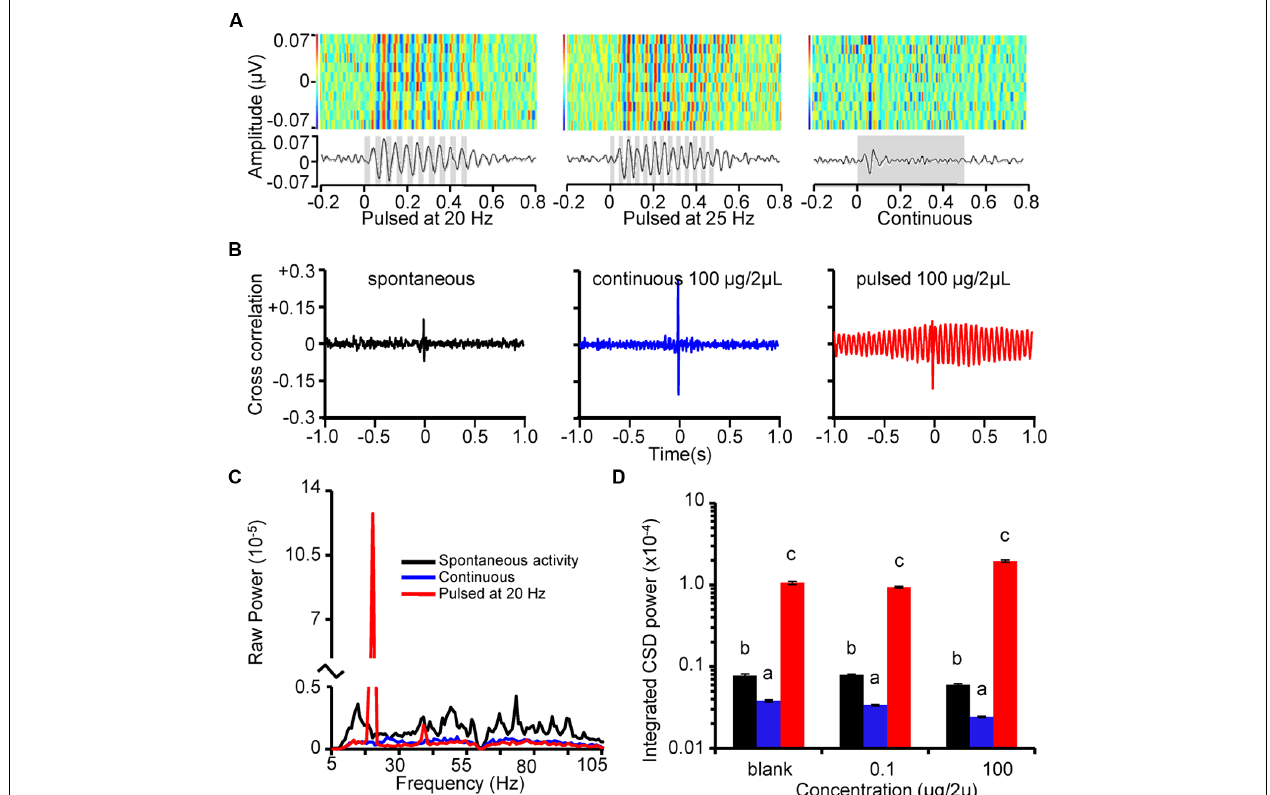
between LFPs and units during spontaneous activity (left), and in response to K6 (100 μ g in 2 μ L mineral oil) presented as a continuous stimulus (center), or a 20 Hz pulse train (right). (C) Mean cross spectral density across all possible analyzed cross correlations. Results based on 80 individually calculated cross correlations across 4 pulse tracking units, 4 LFP recording sites, and 5 stimulus repeats. (D) Mean integrated CSD power in the cross correlations around the pulsing frequency. Results are color coded as in B and broken down as a function of odor concentration. Inset letters indicate significant differences between spontaneous, continuous, and pulsed CSD power at 20 Hz. Analysis was performed independently for each concentration. Note that relative to spontaneous activity, continuous odor stimulation significantly decreased power whereas pulsed stimulation significantly increased power; this was true at each stimulus concentration (Tukey’s HSD; p <